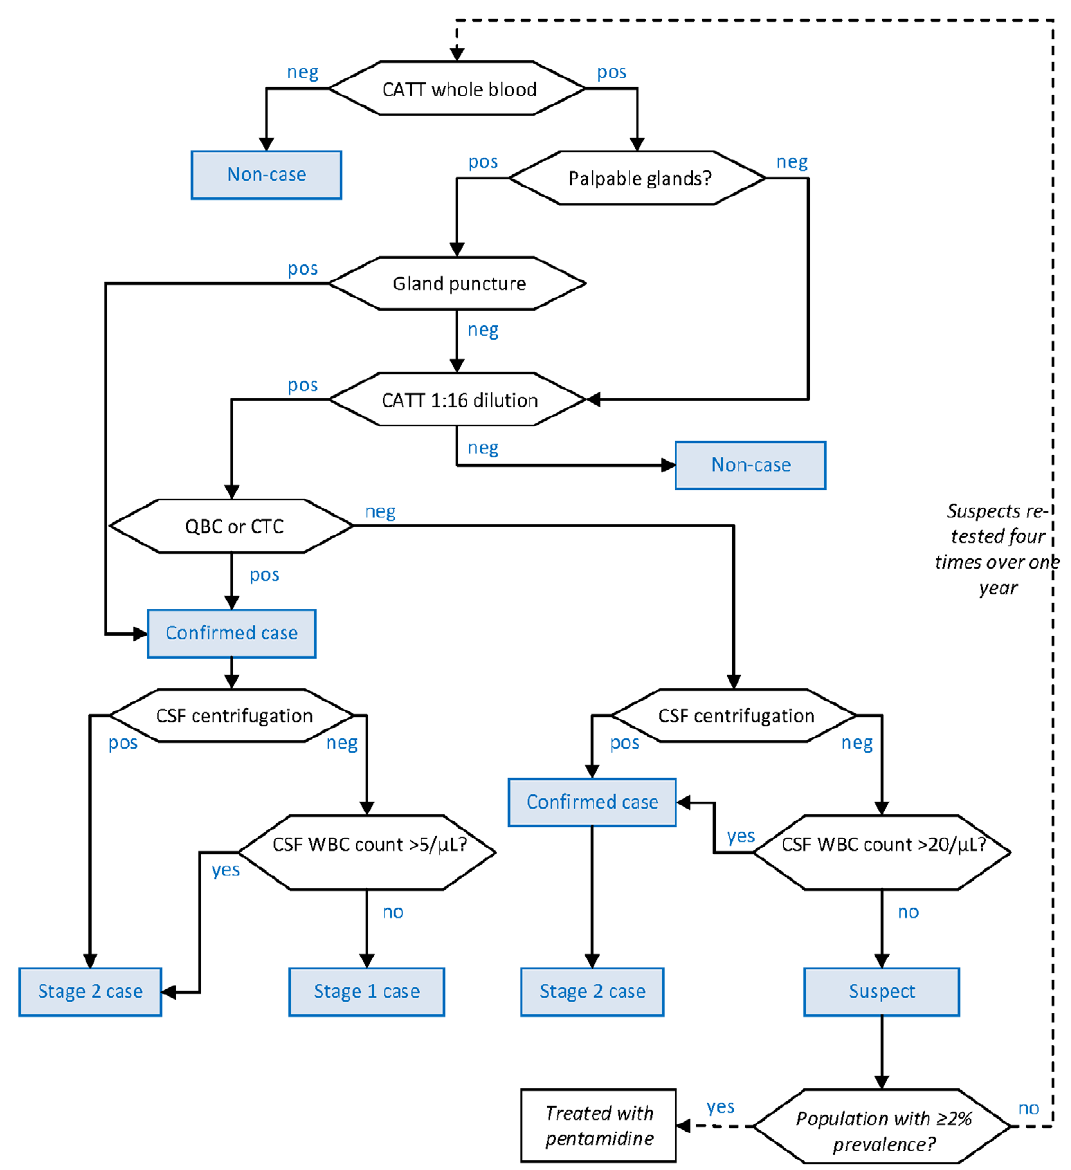
Figure 3. Diagnostic algorithm used in the Kiri, Southern Sudan programme (end of programme). Hexagonal boxes indicate tests. Square, blue-shaded boxes indicate points at which a decision on the patient is